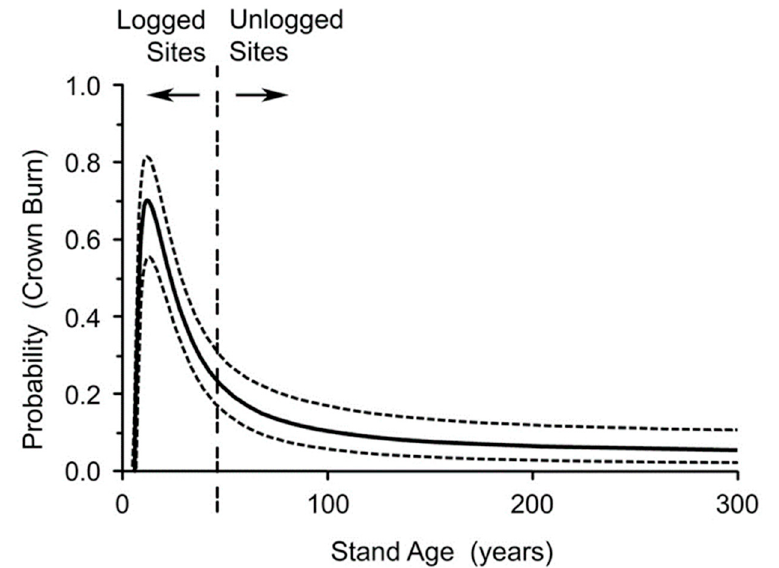
Figure 2. Nonlinear relationship between stand age and the probability of canopy fire or crown burn. The probability of crown burn peaks at ~40 years before declining as stands approach 80–100 years old. Redrawn from Taylor, McCarthy and Lindenmayer [65]. The solid line corresponds to mean response, and the dashed line represents the lower and upper bounds of the 95% confidence interval.